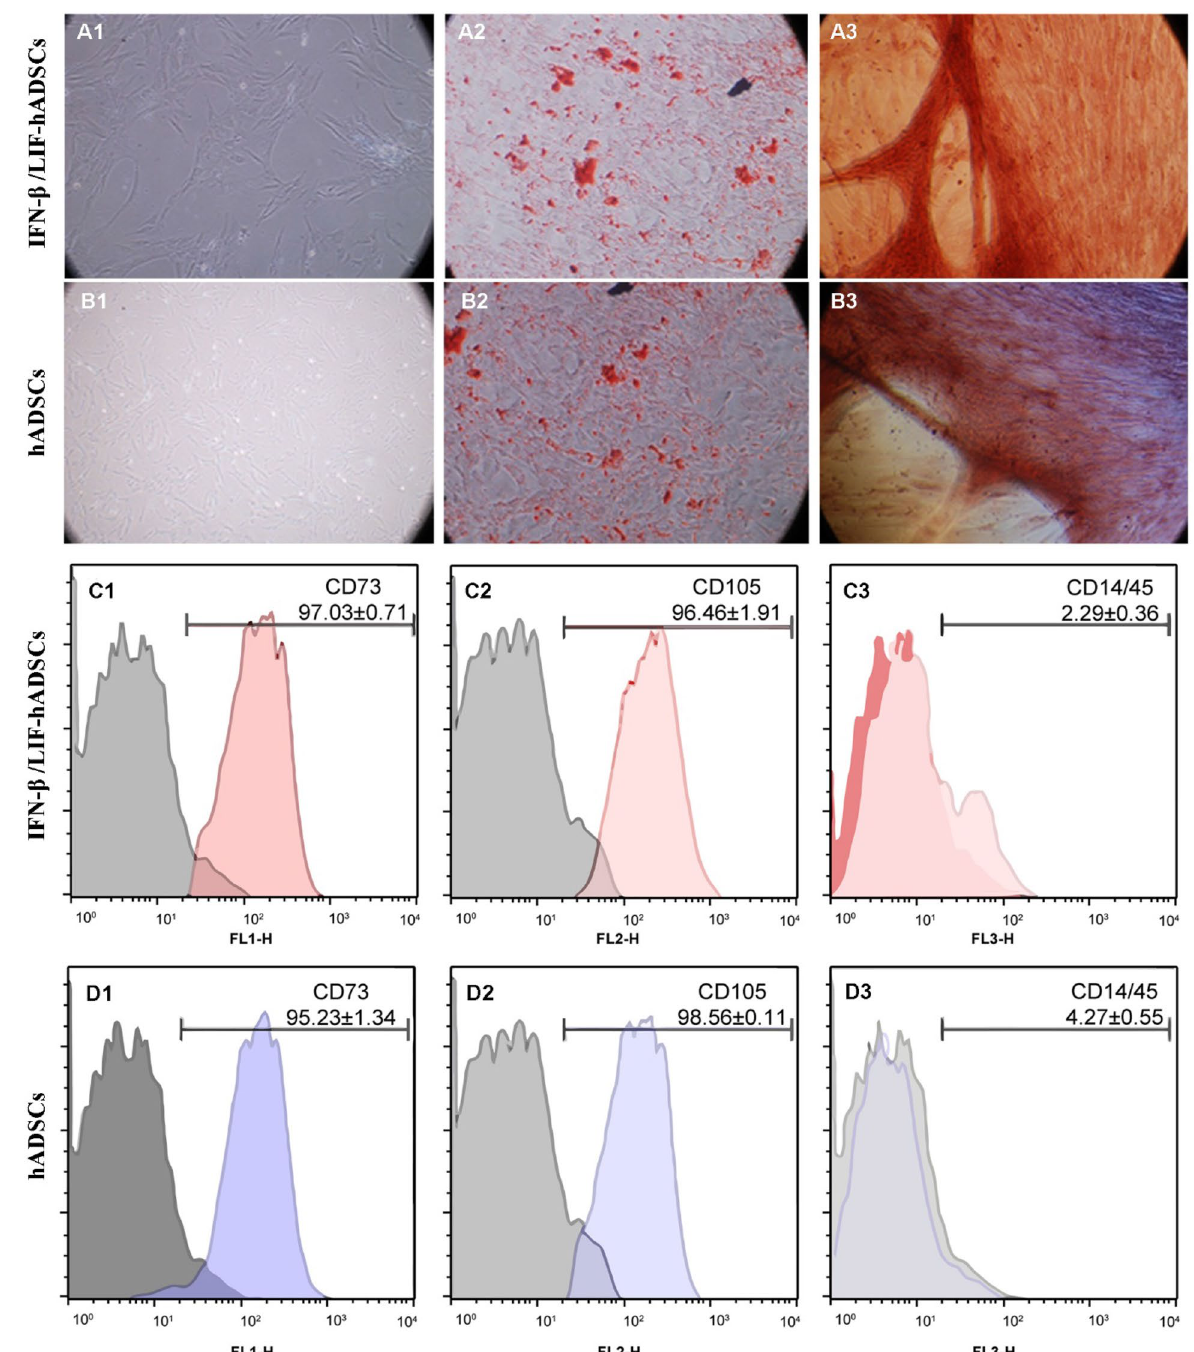
Figure 2. Differentiation potential and cell surface characterization of transduced and un-transduced hADSCs. Phase contrast microscopy ( A1 and B1 ) images show fibroblast-like morphology of transduced hADSCs. For abiogenic and osteogenic differentiation, transduced hADSCs were stained with Oil red ( B2 , A2 ) and Alizarin- Red ( A3 , B3 ), respectively. Scale bar, 100 µm. For the immunophenotypic profile of the transduced hADSCs, the cells were stained with selected CD marker antibodies (positive for CD73 and CD105, negative for CD14/45) ( C , D ). All cells were selected from the 3rd to 5th